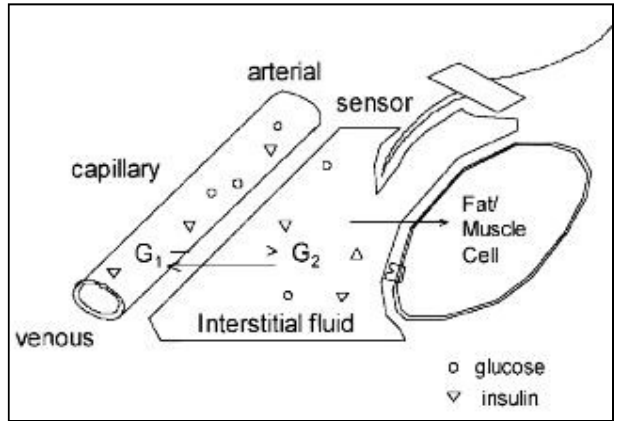
Figure 3. ( a ) An iontophoretic drug delivery system comprising donor and receptor compartments along with a current source and controller. D + : cationic drug; M + : biological cations; X − : biological anions. ( b ) Vyteris Inc. LidoSite TM topical system